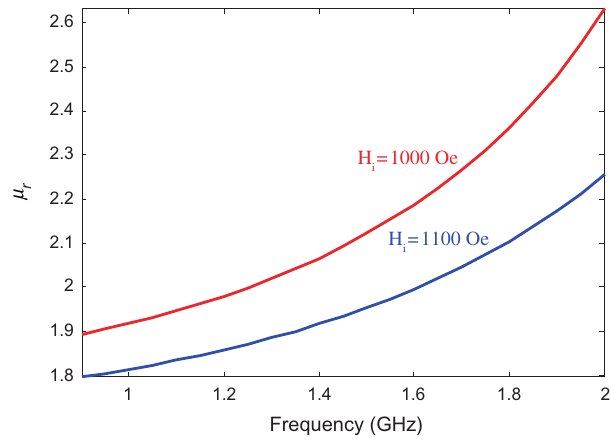
Figure 6. Relative permeability of AL-800 with saturation magne- tization 4 p Ms = 800 G, loss linewidth D H = 30 Oe calculated using Polder’s tensor for internal magnetic field H i = 1000 and 1100